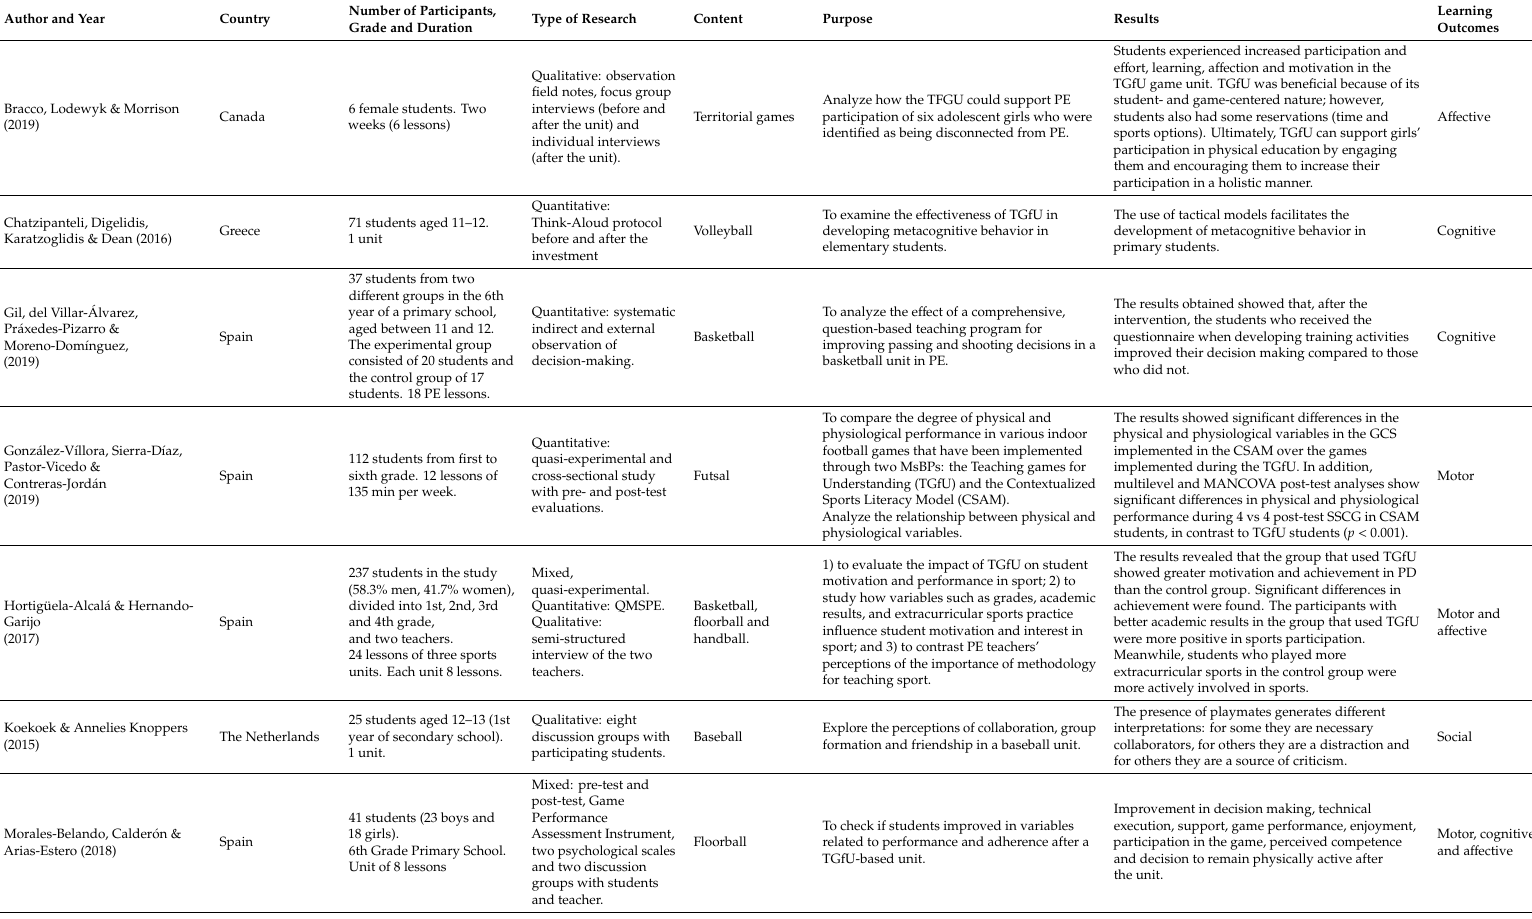
Table 2. Summary of Teaching Games for Understanding (TGfU) articles published between 2014 and